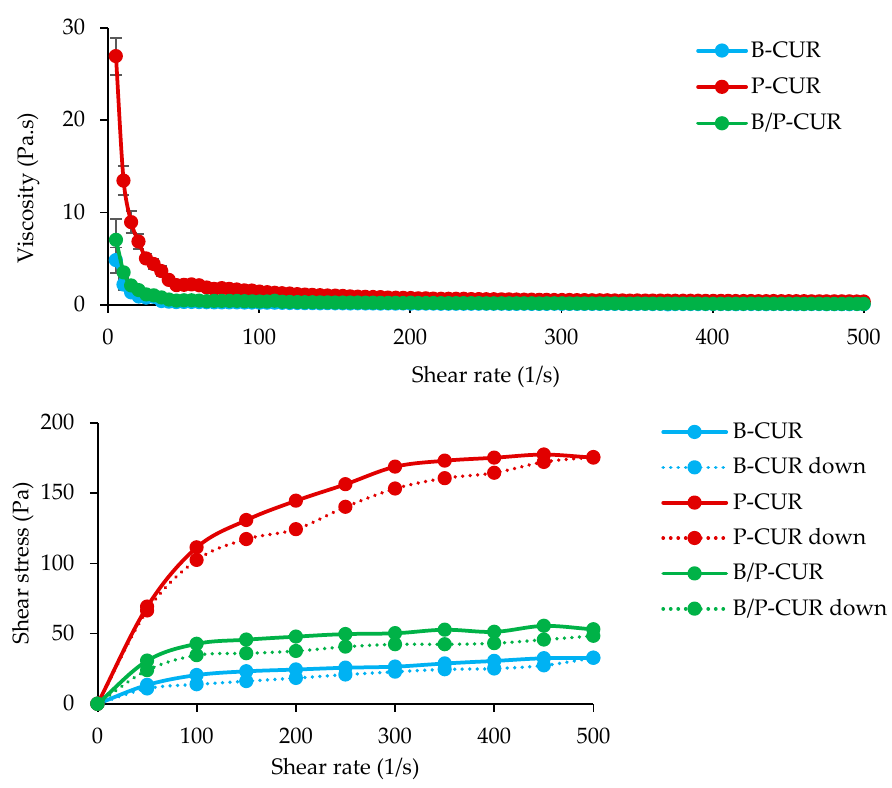
Figure 2. Viscosity profiles (top panel) and flow curves (bottom panel) of B-CUR, P-CUR, and B/P- CUR hydrogels measured up to 500 s − 1 at 32 °C (mean values ± s.d.; n = 3).